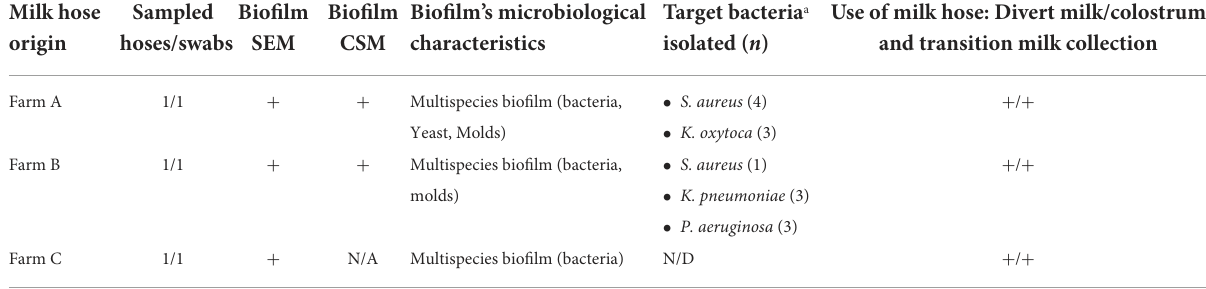
TABLE 1 Characteristics of biofilms on milk hoses utilized to divert milk and colostrum on three Chilean dairy farms, evaluated by scanning electron microscopy (SEM), confocal spectral microscopy (CSM) analyses, and microbiological cultures. Milk